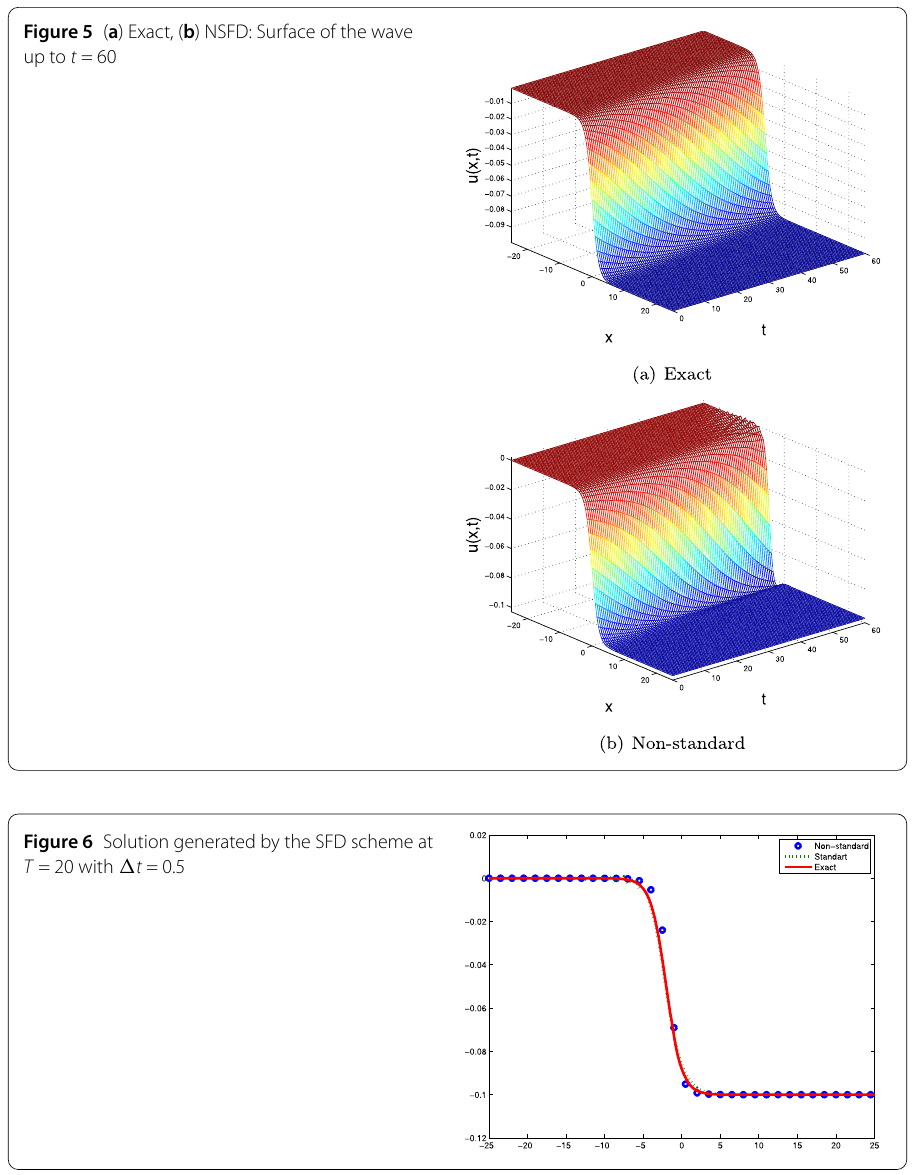
Figure 6 Solution generated by the SFD scheme at T = 20 with (cid:3) t =